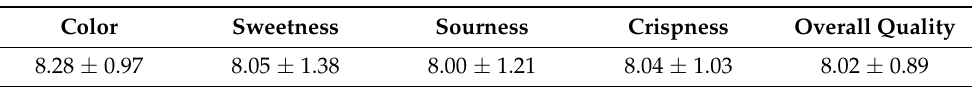
Table 7. Sensory evaluation of mango slices using a combination of greenhouse solar and hot air drying.